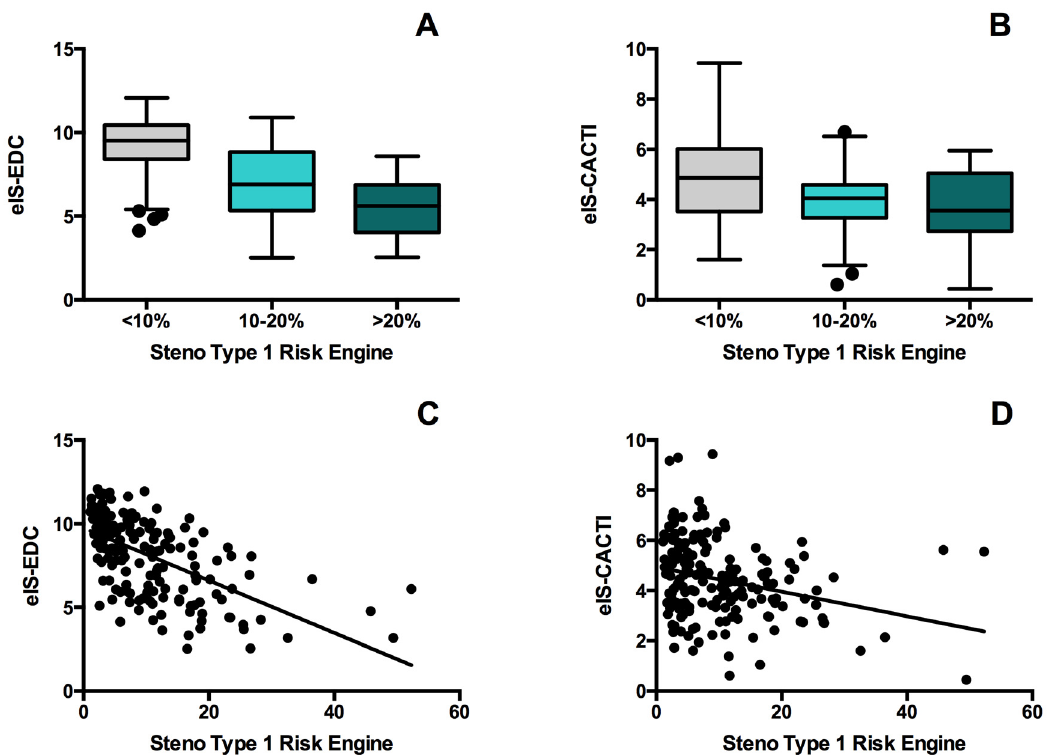
Figure 1. Comparison of eIS-EDC (estimated insulin sensitivity developed from the Pittsburgh Epidemiology of Diabetes Complications Study) ( A ) and eIS-CACTI (estimated insulin sensitivity developed from Coronary Artery Calcification in T1DM Study) ( B ) for the Steno Type 1 Risk Engine low ( < 10%), moderate (10–20%) and high-risk ( ≥ 20%) groups. Spearman correlation coe ffi cient for the association between eIS-EDC ( C ) and eIS-CACTI ( D ) and Steno Type 1 Risk Engine risk score.